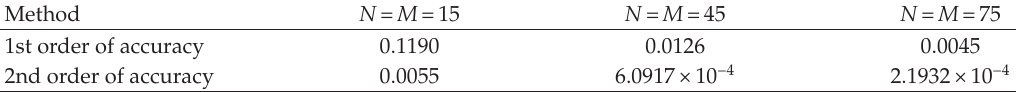
Table 1: Comparison of exact solution and approximate